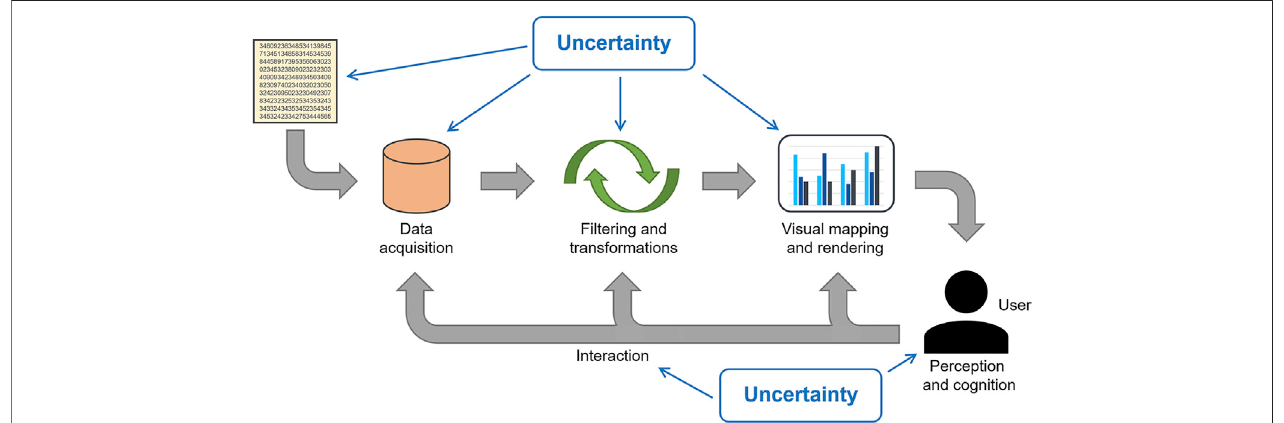
FIGURE 1 | Visualization pipeline including